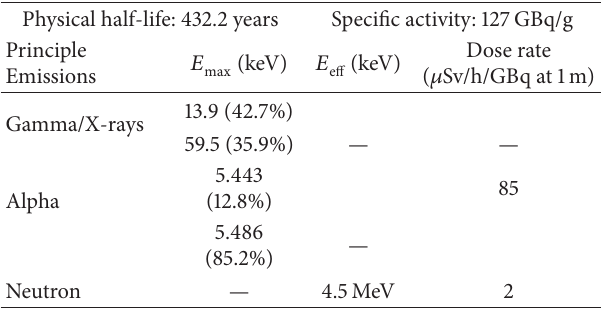
Table 4: Radiation characteristics of 241 Am-Be neutron source 1